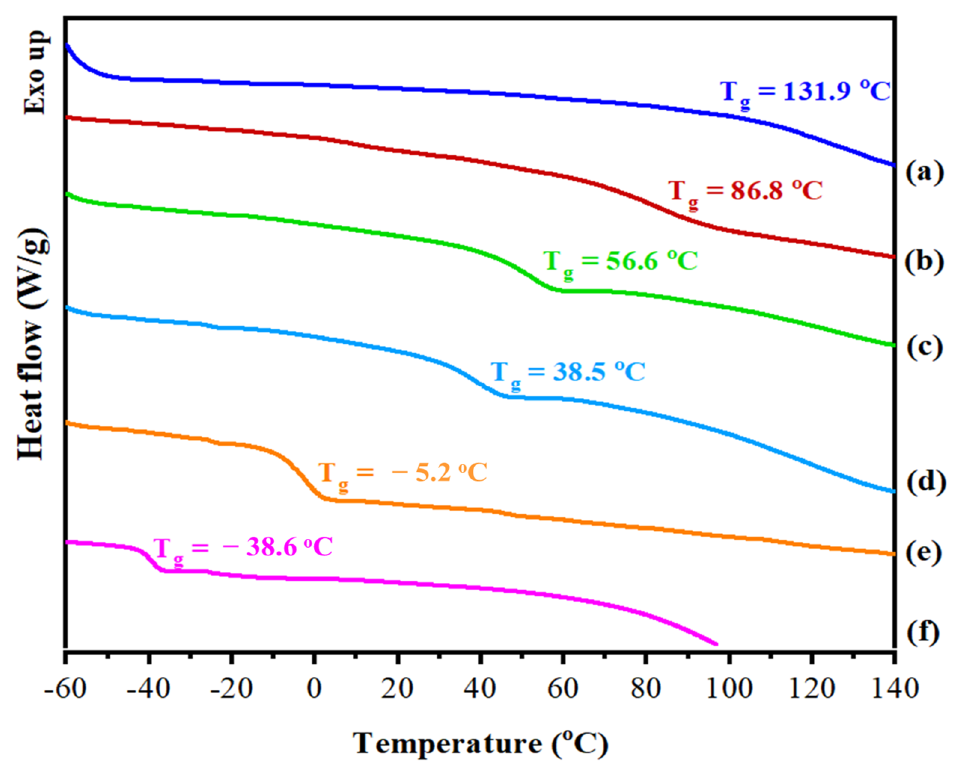
Figure 7. DSC thermogram of CHI (a), their blends (b–e), and P3HPEI (f). Content of P3HPEI in the blends: 20 ( b), 40 ( c), 60 ( d), and 80% ( e). blends: 20 (b), 40 (c), 60 (d), and 80% (e).